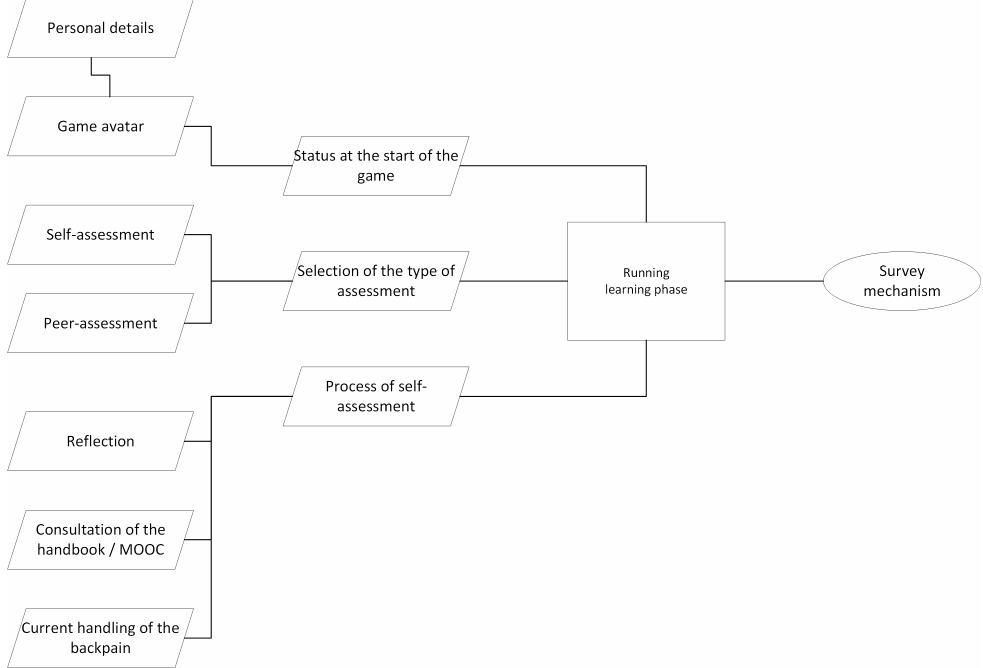
Figure 5. Ontology based approach—level